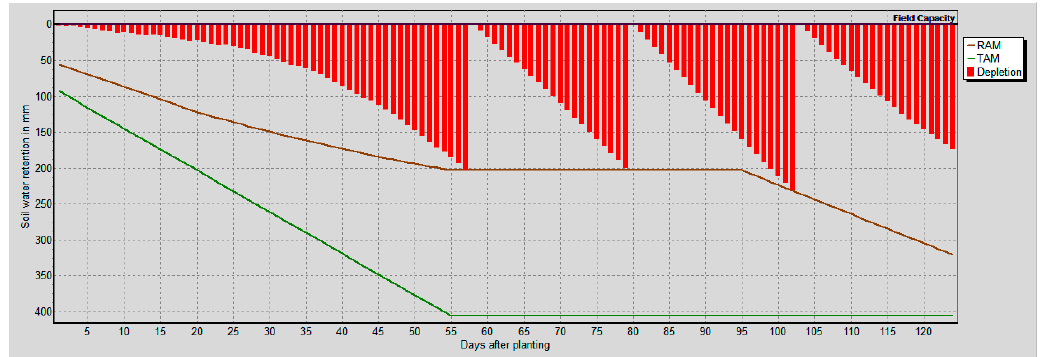
Figure 4. Irrigation schedules for white corn.